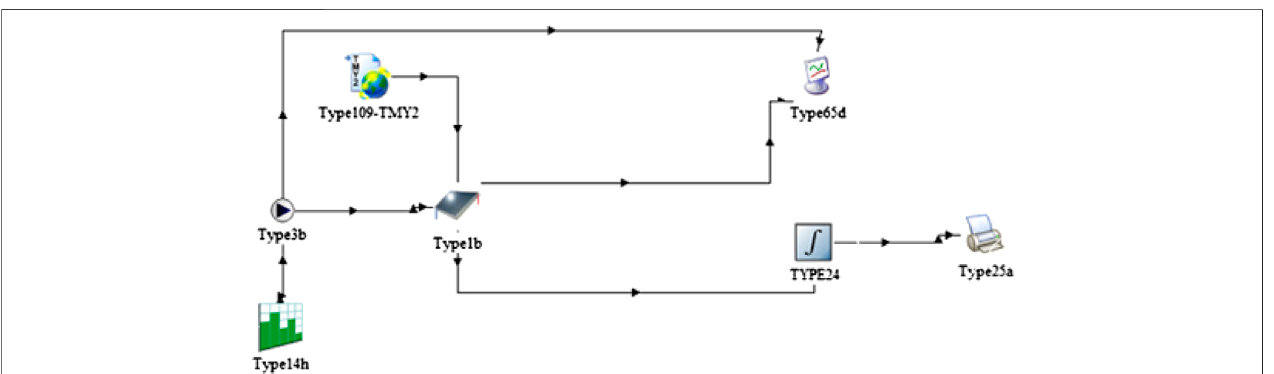
FIGURE 1 | Arrangement of the components in TRNSYS for the simulation process where direct solar collector is of Type 1b, weather condition is Type 109, and printer is Type 25a.